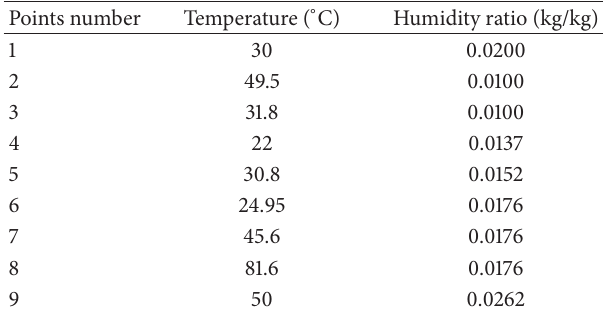
Table 2: Air properties of one-stage solar desiccant cooling system in ventilation